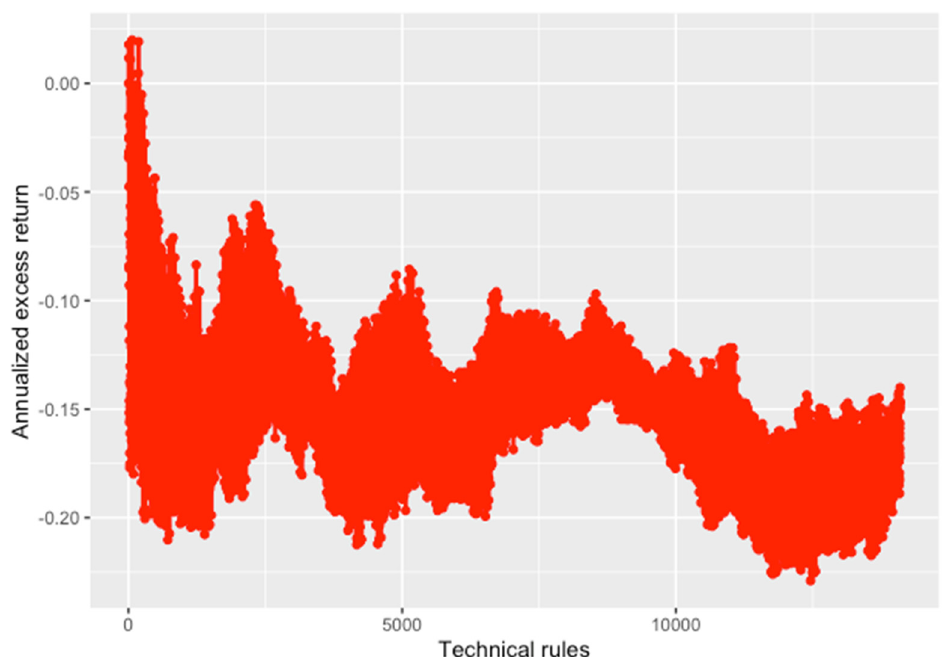
Figure 4. Annualized excess returns achieved by all 14,100 SMA crossover rules for the Brent market over the 1999–2019 period.